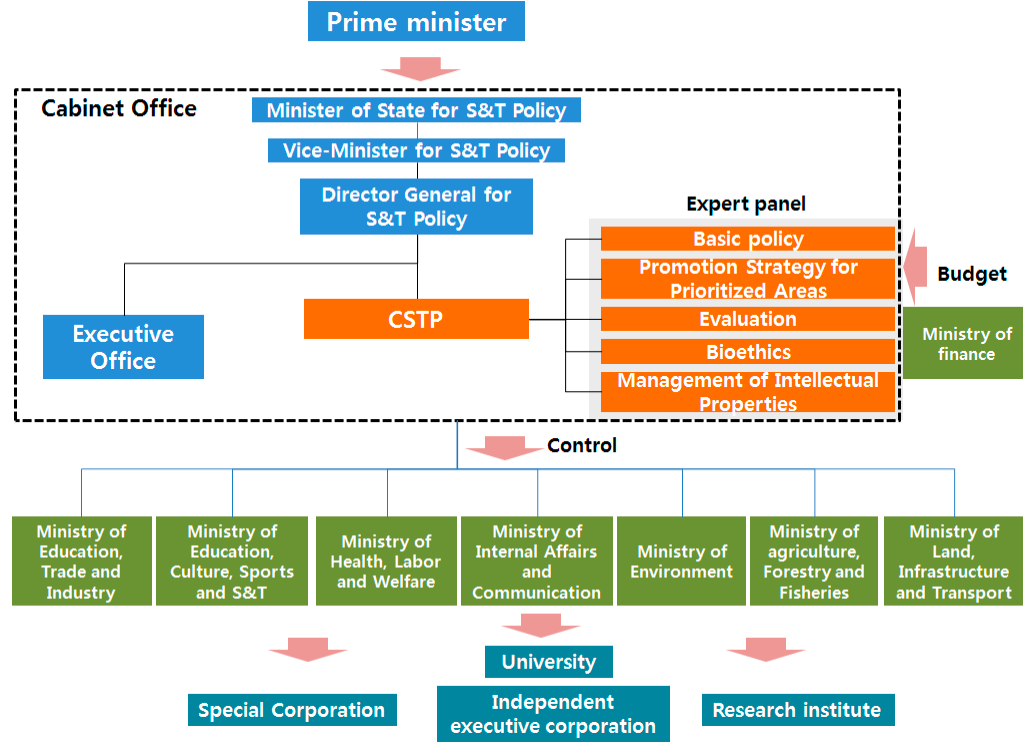
Figure 3. Overall organizations related to science and technology (S&T) policy in Japan.